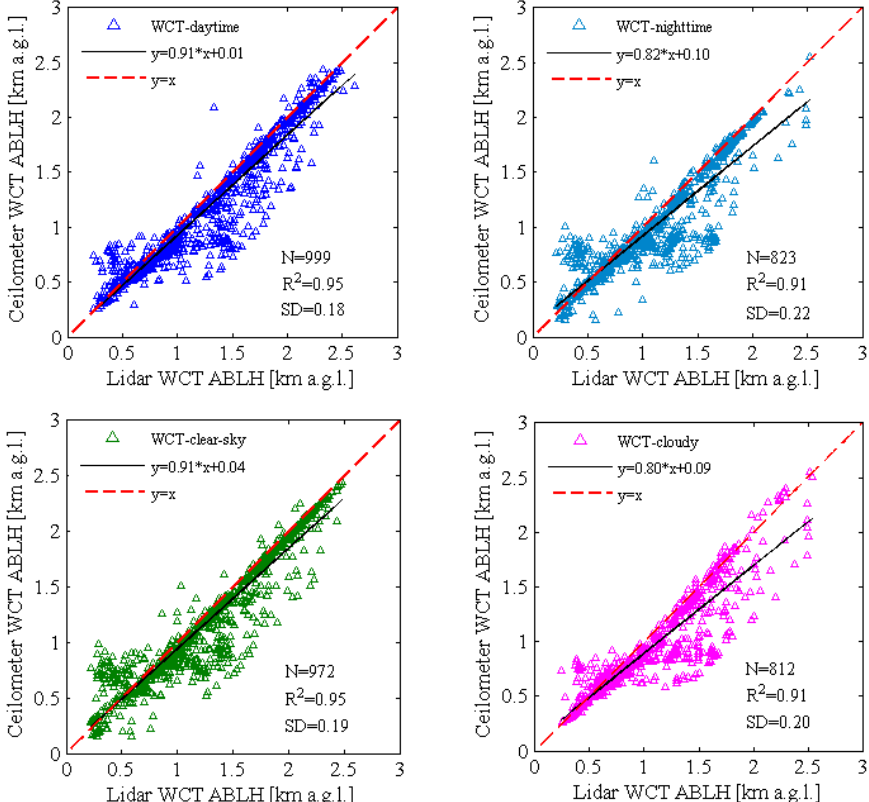
Figure 4. Correlation plots of the ABLHs derived from the PollyXT lidar and the CHM15k ceilometer using the wavelet covariance transform (WCT) algorithm for the collocated measurements from July to October 2013 in Warsaw. In blue, measurements at daytime; and in light blue, at night. In green, measurements in clear sky; and in pink, for boundary layer clouds. Each data point represents the 10 min average.